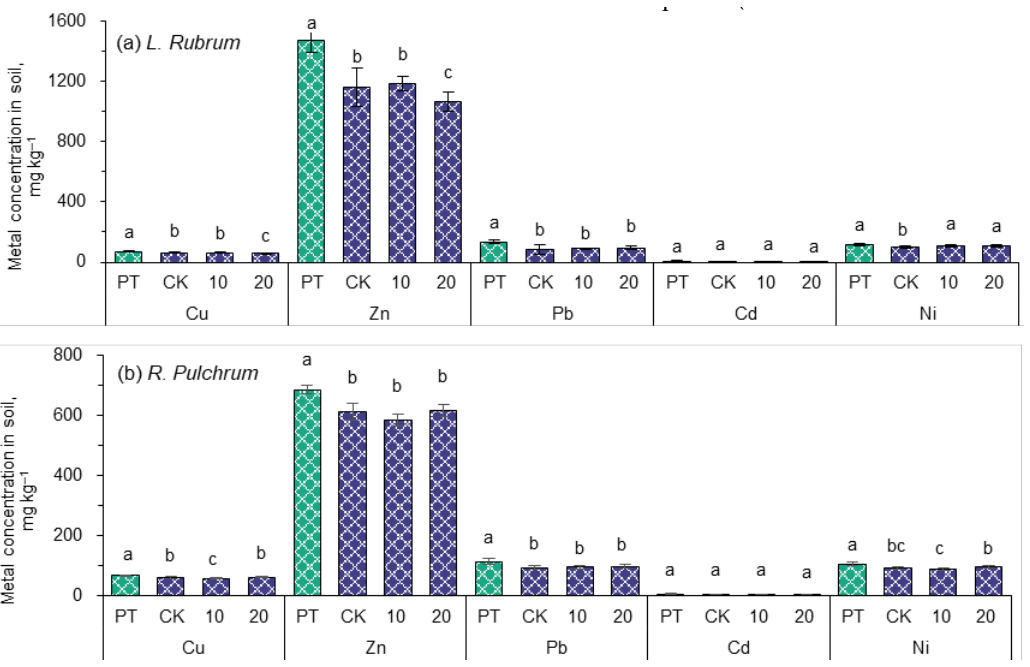
Figure 4. The effects of planting garden plants ( a ) L. rubrum , ( b ) R. pulchrum and applying IAA on residual concentrations of heavy metals in soil. The soil residual concentrations of heavy metals after planting garden plants and applying IAA. Different letters indicate significant differences among the treatments, p < 0.05. The posthoc test was performed with Tamhane method. PT indicates samples of pre-treatment, while CK, 10, and 20 are IAA treatments at 0, 10, and 20 mg L − 1 , respectively.